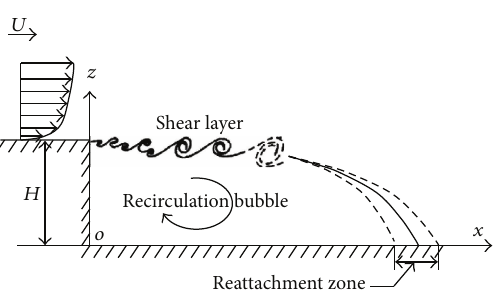
Figure 1: Two-dimensional flight deck flow field.